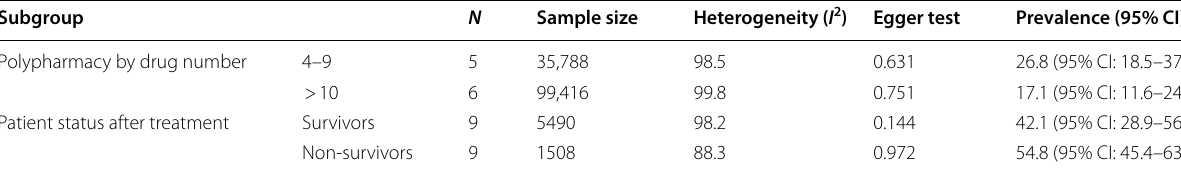
Table 3 Subgroup analysis of results by number of drugs and status of patients with COVID‑19 after treatment